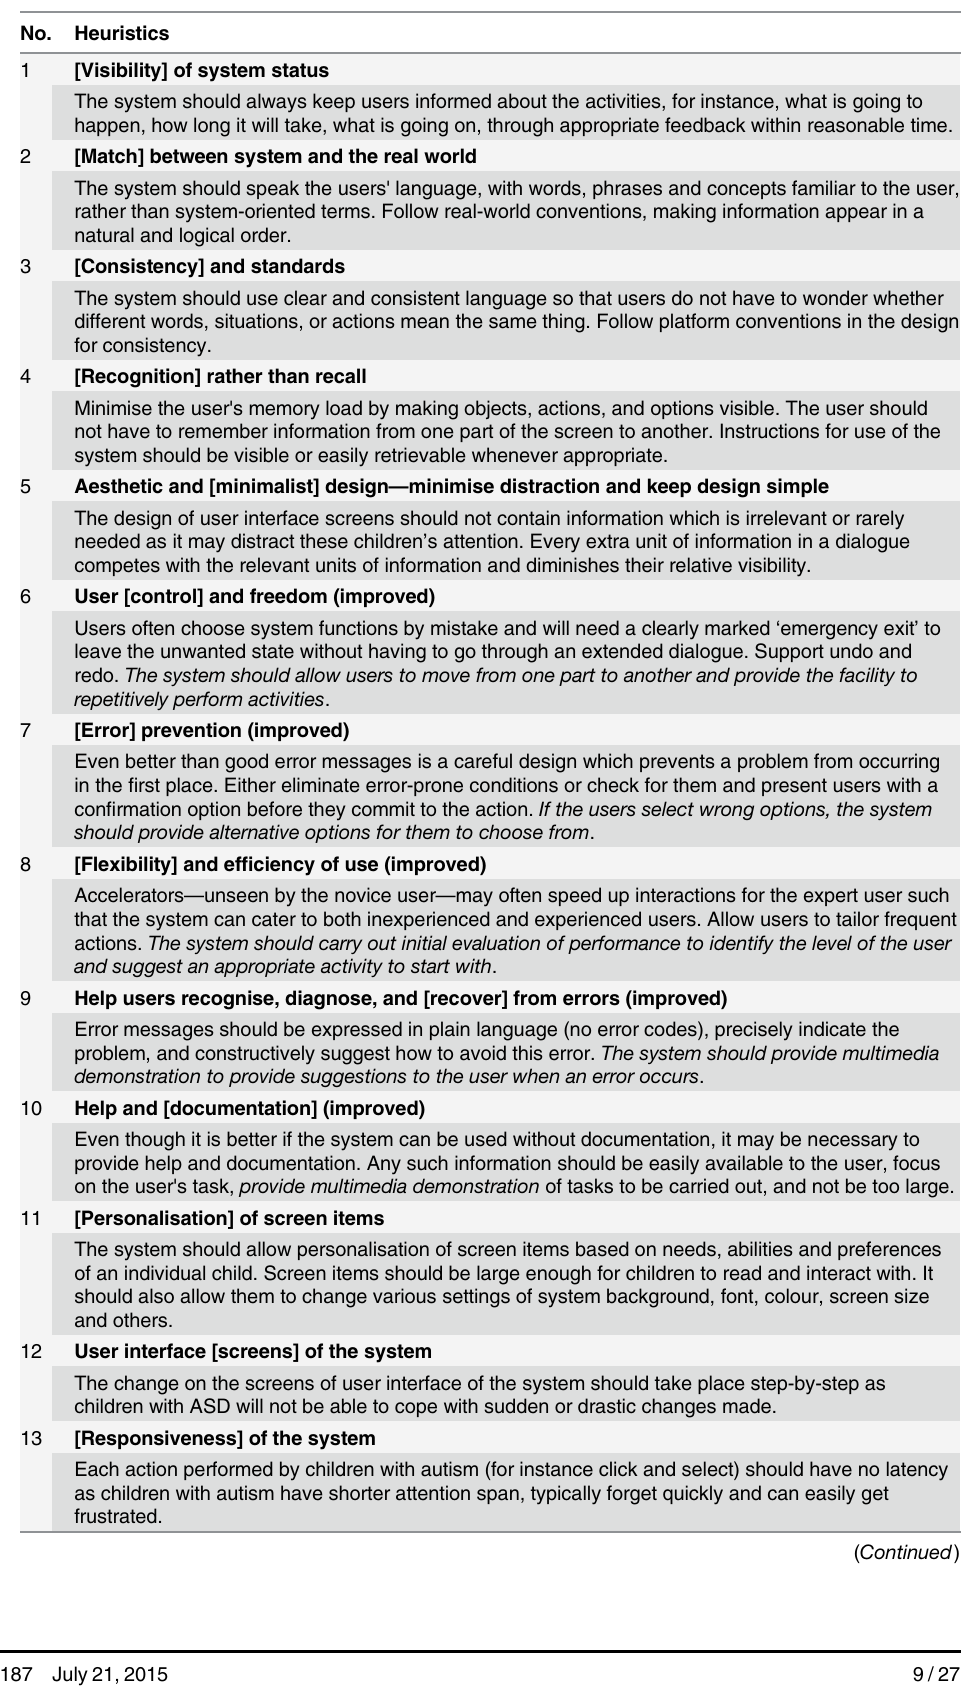
Table 2. Modified set of